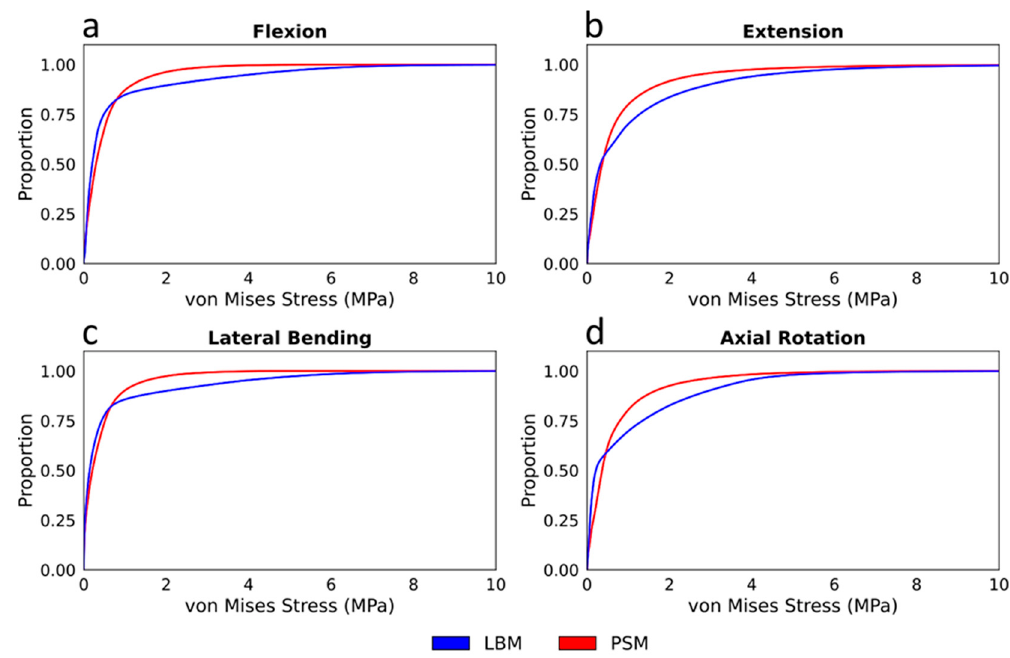
Figure 7. Empirical Cumulative Distribution Functions of the von Mises stress values against pure ( a ) flexion, ( b ) extension, ( c ) lateral bending, and ( d ) axial rotation in the bony elements of the L2, L3, and L4 vertebra.